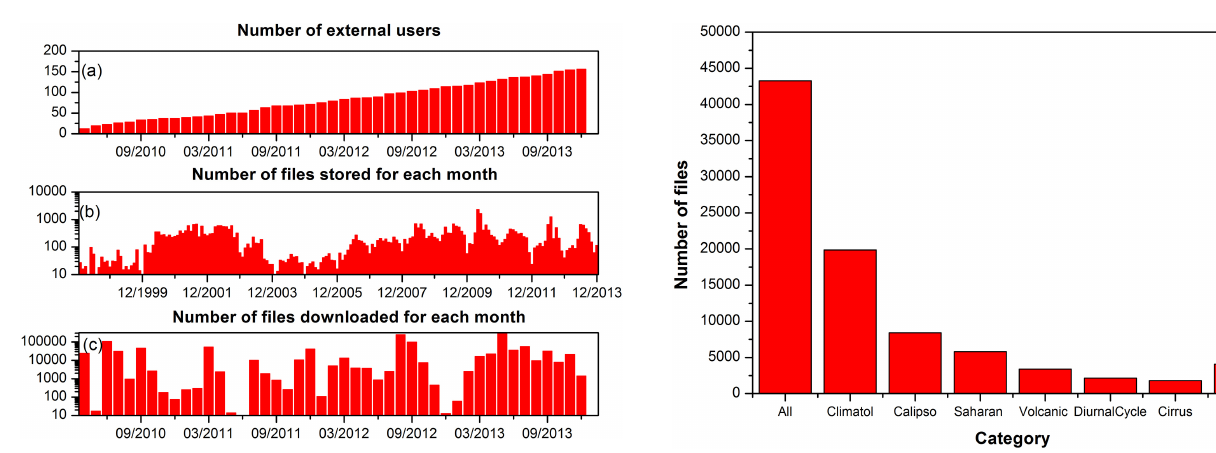
Figure 7. EARLINET database: distribution of data files in the dif- ferent categories: climatology, CALIPSO, Saharan dust, volcanic eruptions, diurnal cycles, cirrus, and others (forest fires, photo smog, rural or urban, and